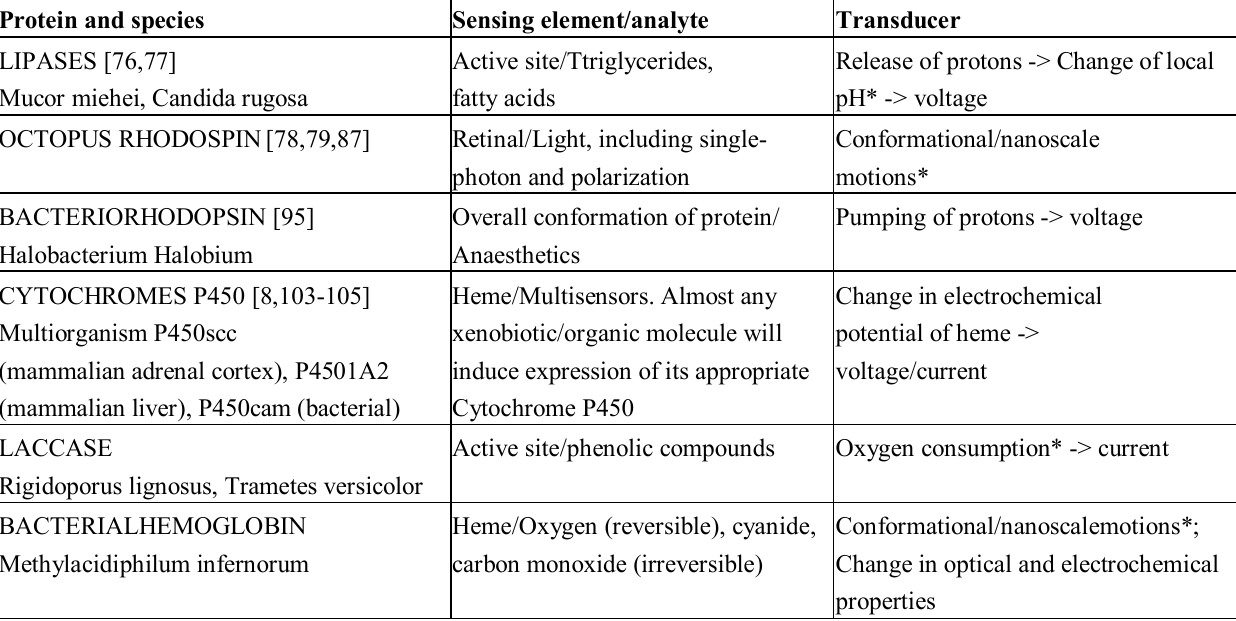
Table 4. Examples of sensors originating from protein Langmuir-Blodgett technology. Protein and